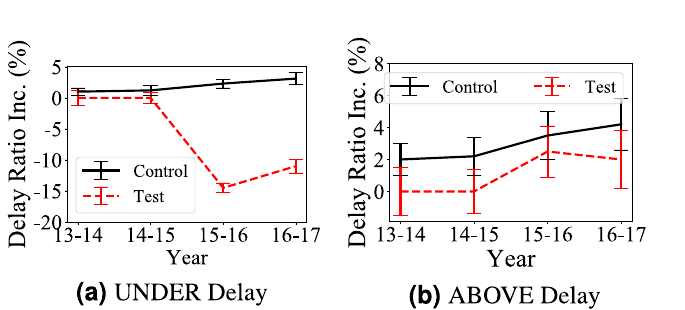
Figure 5. Delay increase in underground or aboveground areas with underground upgrades (test areas) and similar areas have no aboveground upgrades (control areas).